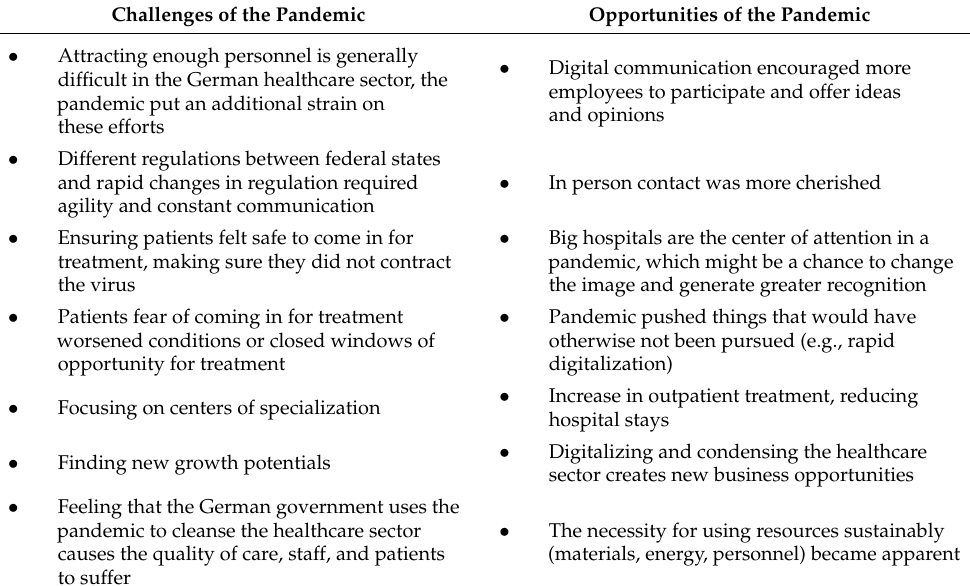
Table 5. Cont. Challenges of the Pandemic Opportunities of the Pandemic